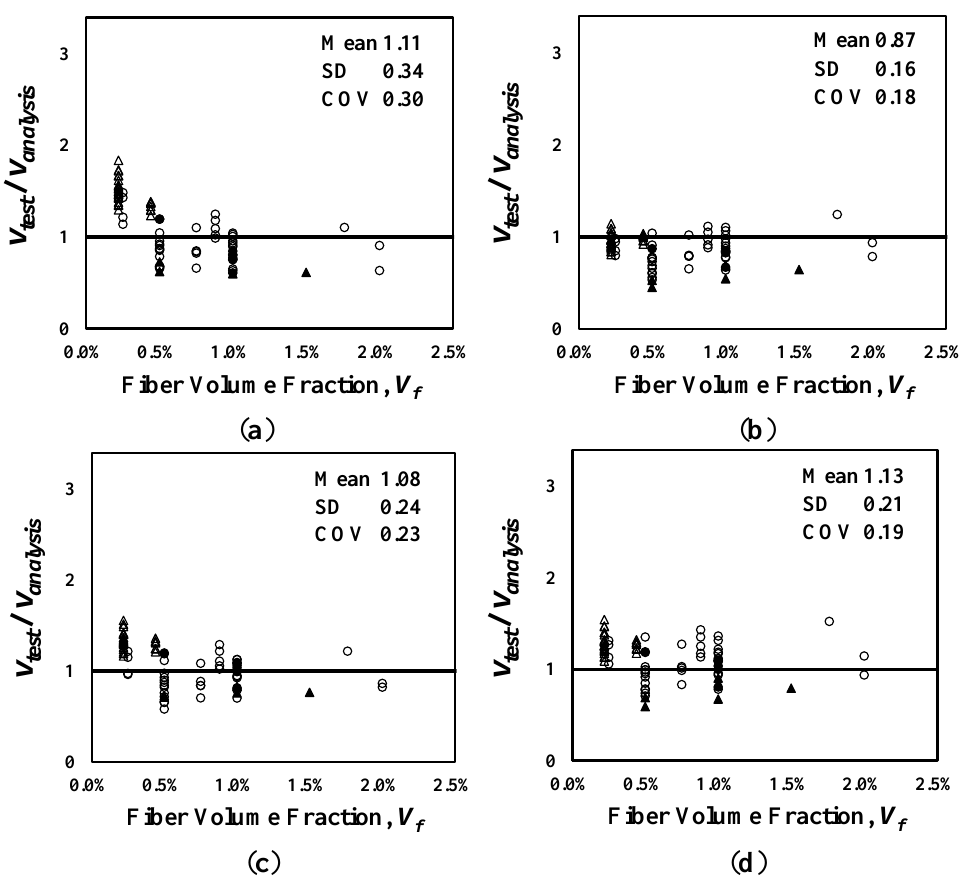
f  ≥ 50 MPa, a / d < 4; c